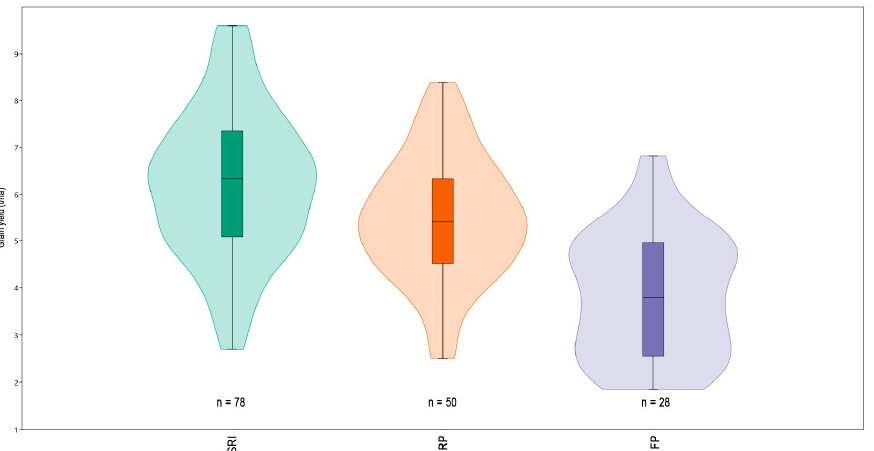
Figure 1. Violin plots of rice grain yield obtained under SRI, RPs, and FPs. (SRI: system of rice intensification; RPs: recommended practices; FPs: farmer practices). n = number of data points in each category.